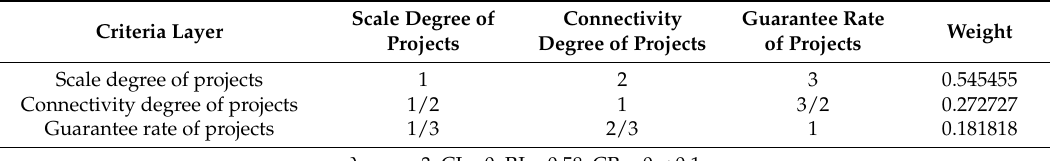
Table 5. Judgment Matrix of Target